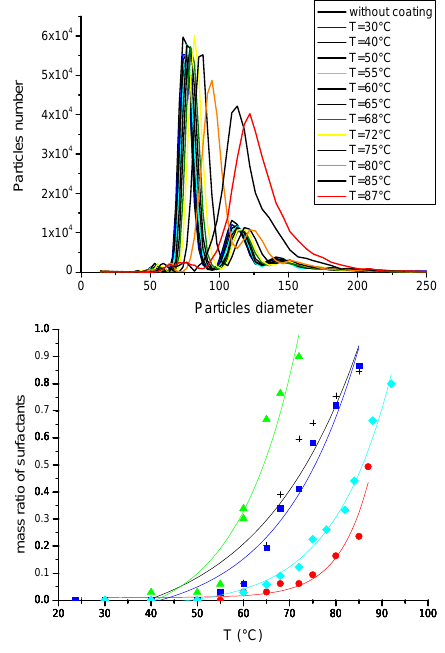
Fig. 2. (a) Particle size distributions of a monodisperse dry aerosol (KI) exposed to lauric acid (C 12 ) in the evaporator at different tem- peratures. (b) Evolution of the mass ratio of surfactants as a func- tion of the evaporator temperature (black crosses: C 9 , red circles: C 12 , green triangles: C 15 , blue squares: C 18 and turquoise dia- monds: C20). The solid lines are only guides to the